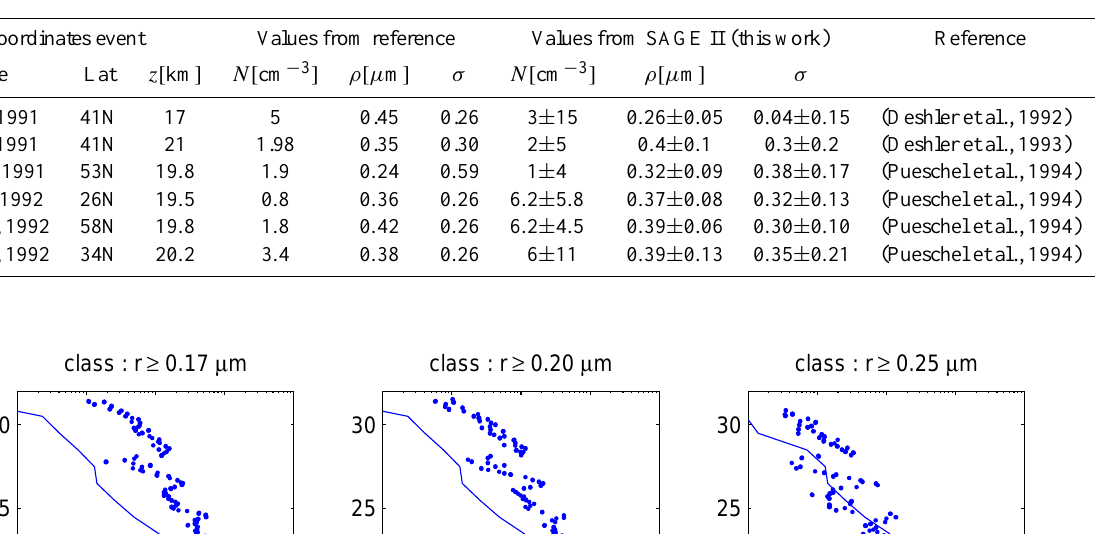
Table 1. Comparison between aerosol parameter values from various reference sources and binned values from SAGE II (this work); when the cited observations refer to a bimodal distribution, only the coarse mode, well detected by the SAGE II wavelength range, is mentioned